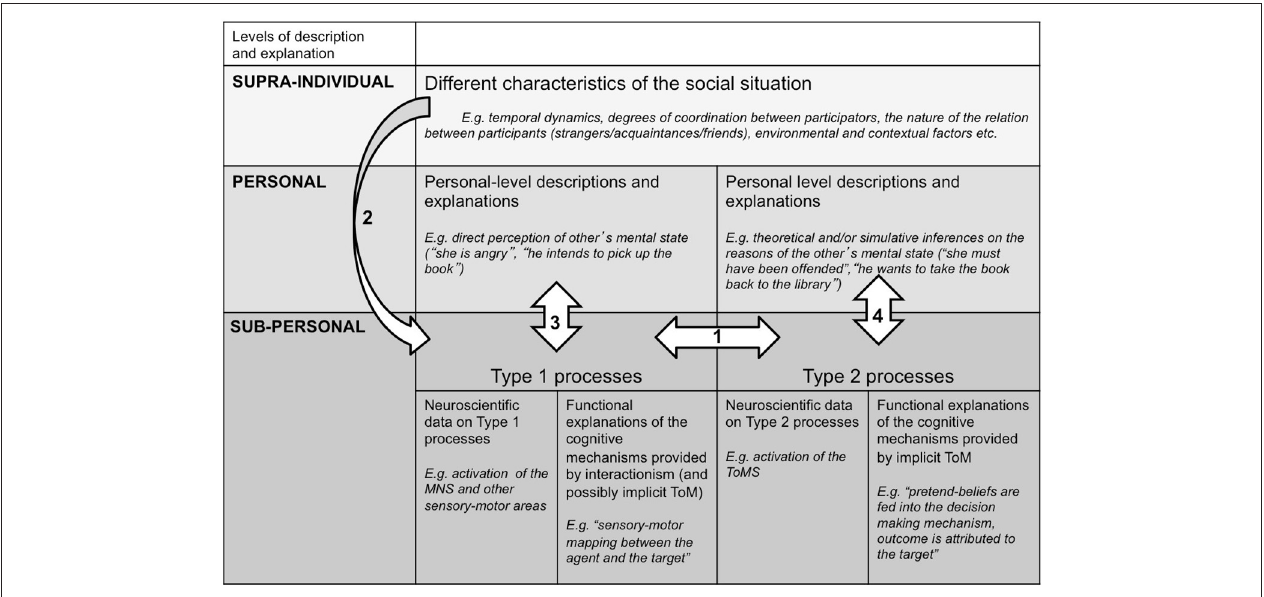
FIGURE 1 | Bohl and van den Bos’ 2012 integrative framework for social cognition (Figure as originally published in Bohl and van den Bos (2012))